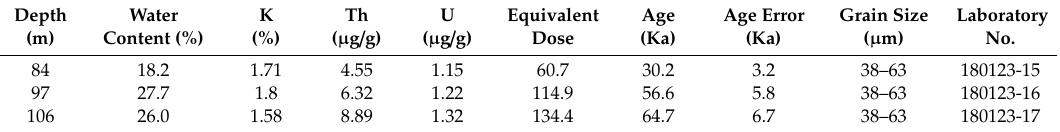
Table 2. Optically Stimulated Luminescence (OSL) ages of core